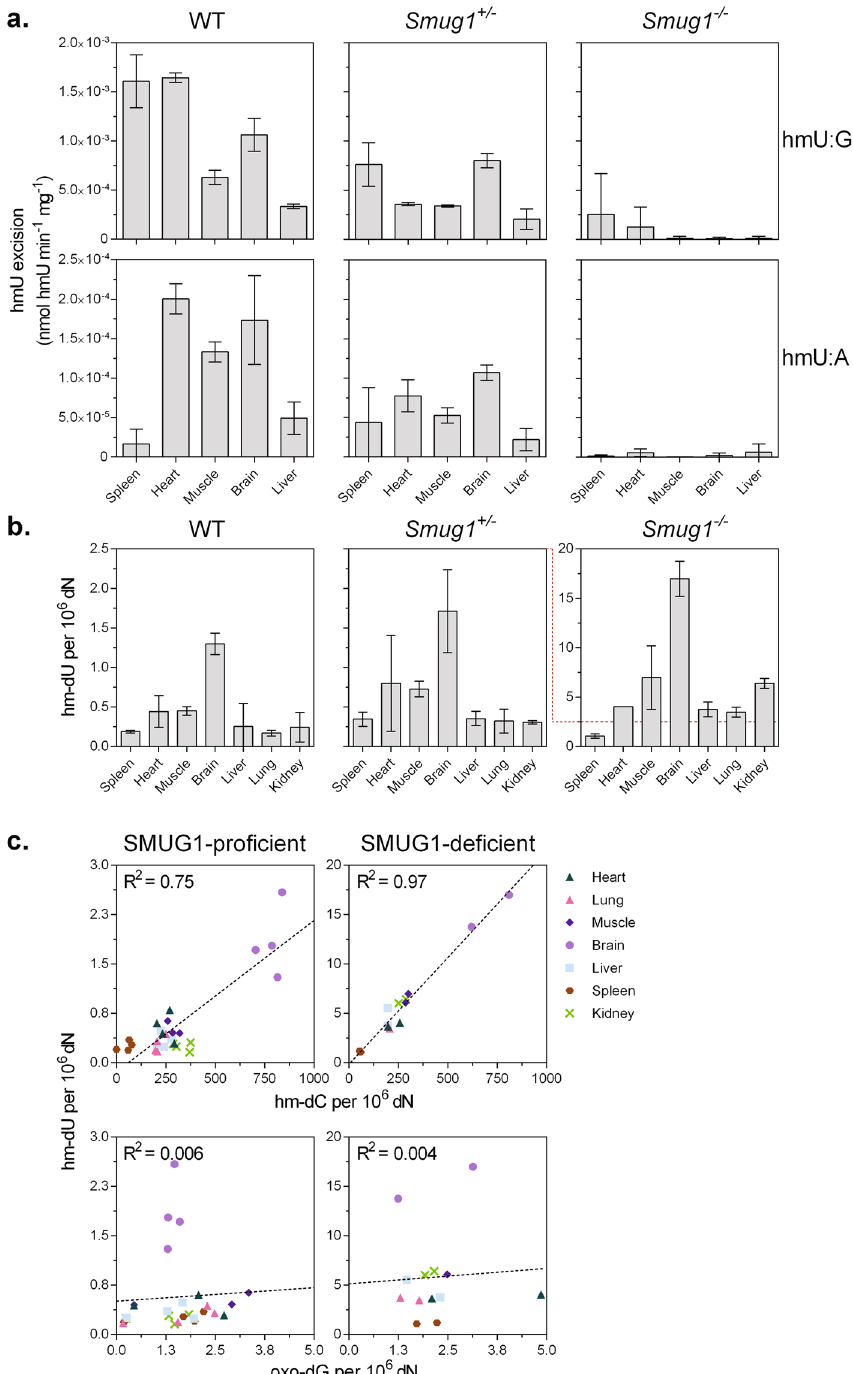
Figure 1. SMUG1 is responsible for hmU-excision activity in mouse tissues. ( a ) hmU excision activity measured in oligonucleotides containing a single hmU:G (top panel) and hmU:A (lower panel) base pair. Heterozygous SMUG1 knockout reduces, whereas homozygous knockout abolishes hmU excision activity. Biochemical assays were evaluated using two-tailed t-test 95% confidence level. ( b ) hm-dU levels (presented as the number of hm-dU residues per million nucleosides) increases in DNA from homozygous but not heterozygous SMUG1 knockout organs. Error bars indicate SD of three biological replicates. ( c ) hm-dU and hm-dC levels (upper panels) correlate strongly in the SMUG1-proficient group (R 2 = 0.75, p < 0.0001) and very strongly in the SMUG1-deficient group (R 2 = 0.97, p < 0.0001), whereas hm-dU and oxo-dG levels (lower panels) do not correlate. The effect of SMUG1 and UNG knockout on genomic lesion levels were assessed using an unpaired t-test or analysis of variance